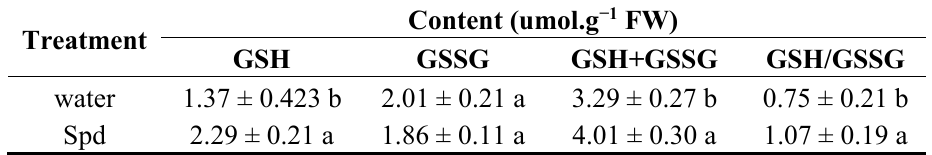
Table 5. The effect of seed priming with water or spermidine (Spd) on reduced glutathione (GSH) and glutathione disulfide (GSSG) content in seeds of white clover after 7 days of germination under 15% PEG. Values are mean ± SE ( n = 6). Different letters in a vertical column indicate significant difference between two treatments. LSD ( p ≤